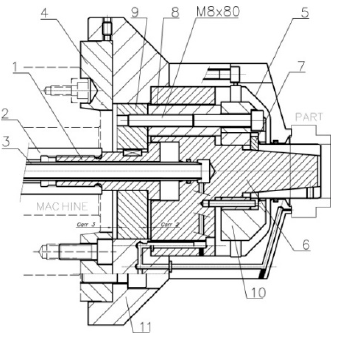
Figure 3. Joint view section.